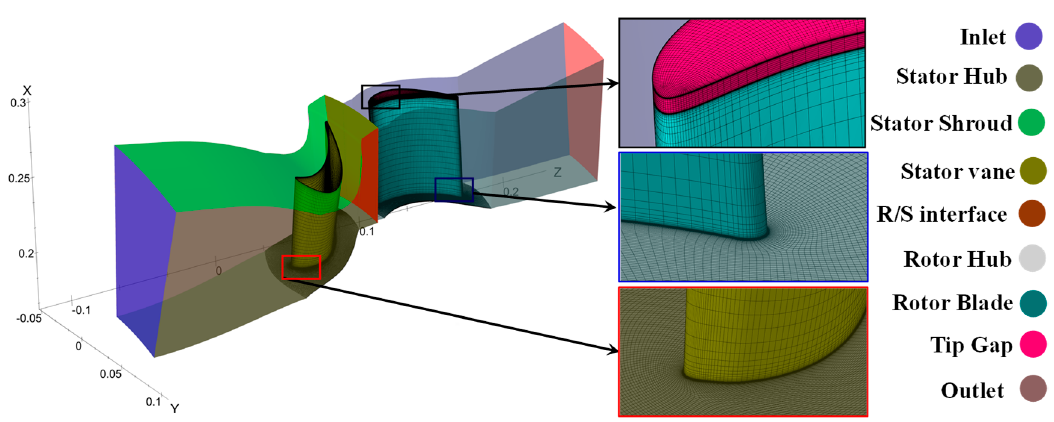
Energies 2019 , 12 , x FOR PEER REVIEW